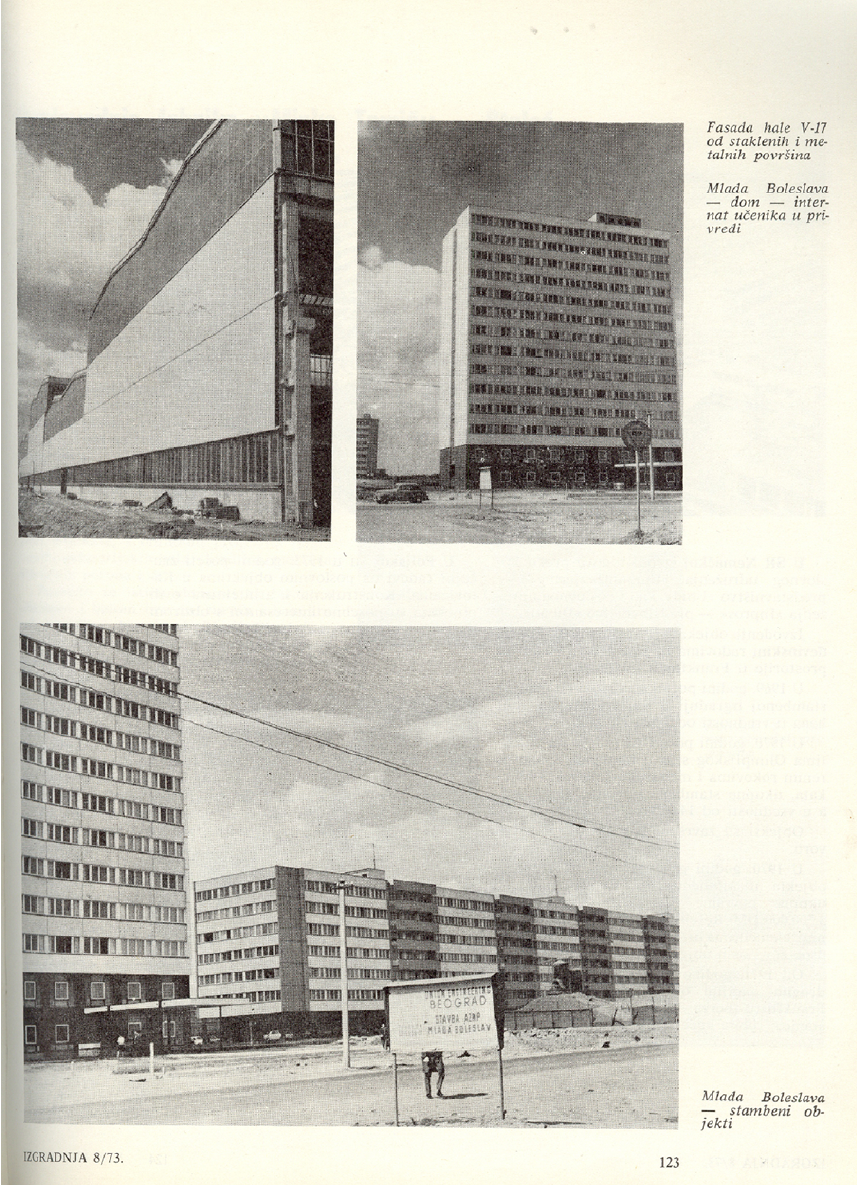
Buildings in Mladá Boleslav, Czech Republic: Hall V-17 of the Škoda factory, Boarding School and mass housing. Fea- tured in the journal Izgradnja , no. 8 (1973), special issue cele- brating the 25th anniversary of KMG